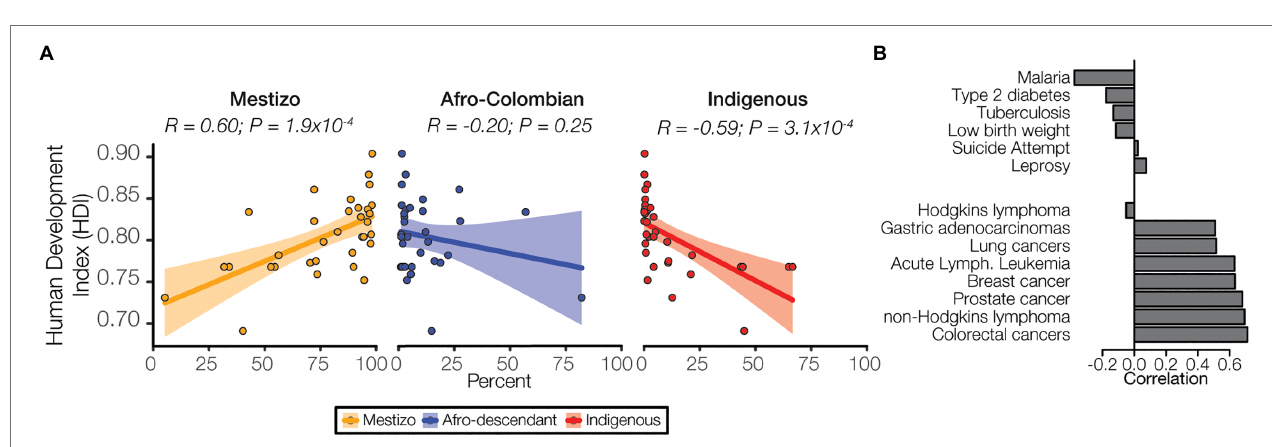
FIGURE 7 | Ethnicity, socioeconomic status, and disease. (A) Human develop index (HDI) values for each administrative department are correlated with ethnic group population percentages for each department: Mestizo (orange), Afro-Colombian (blue), Indigenous (red). Each point represents a single department, and the linear trend is indicated for each ancestry along with 95% CI (shaded area). Pearson correlation coefficient and p -values are shown for each. (B) Correlations between prevalence and HDI are shown for six non-cancer conditions (top) and the eight cancers